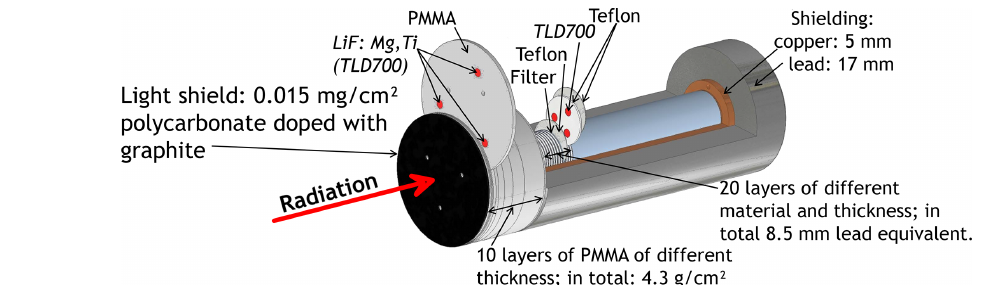
Figure 1. Sketch of the TLD-based spectrometer. Basic principle: the deeper the radiation penetrates the spectrometer, the higher its energy.